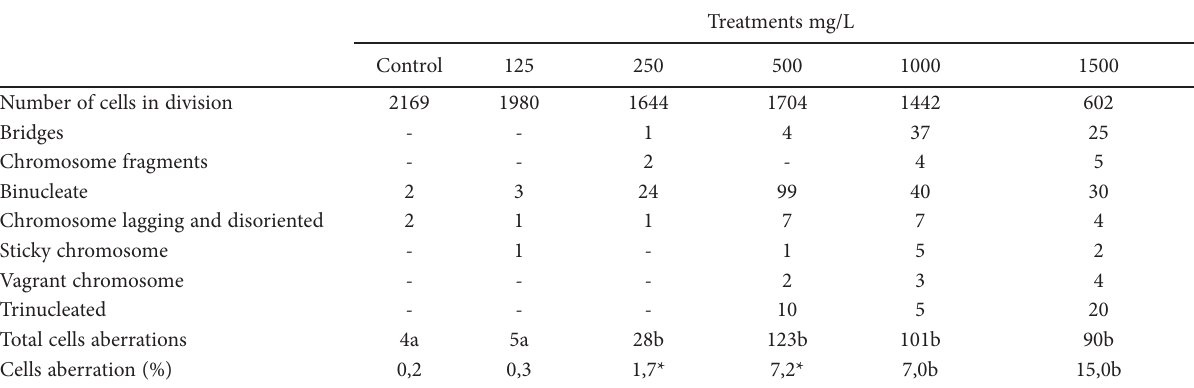
Table 3. Cellular abnormalities observed in Allium sativum exposed to the ethanolic extract of Sambucus